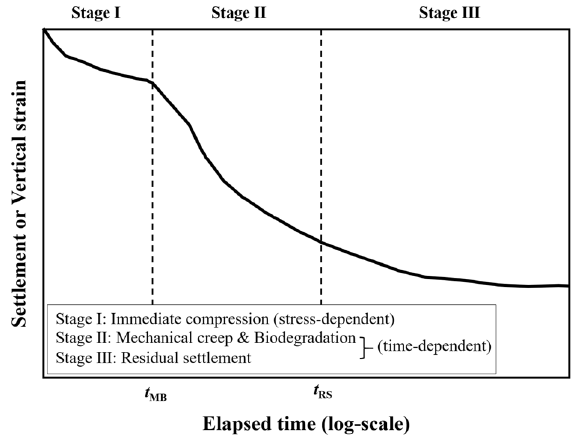
Figure 1. Conceptual waste settlement mechanisms of MSW